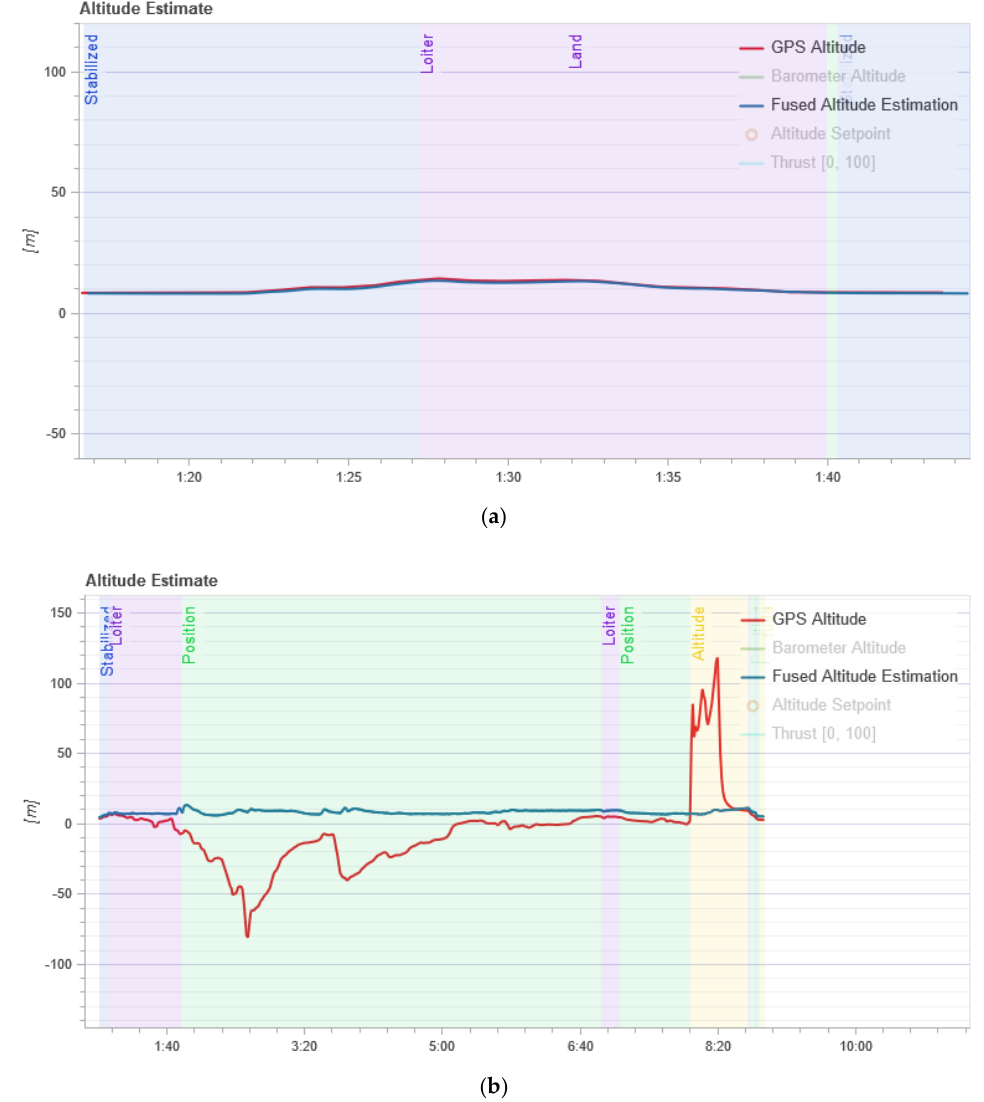
Figure 5. Readings of flight altitude sensors: ( a ) In the normal mode; and ( b ) during a GPS attack.